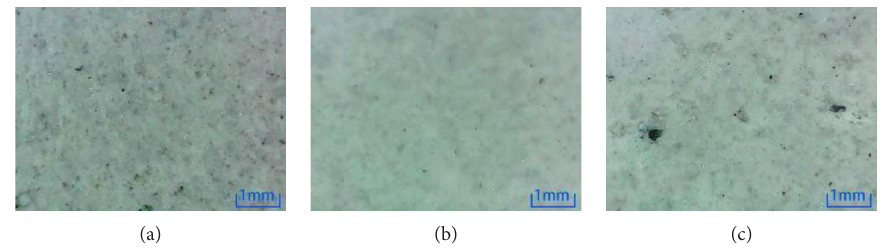
Figure 22: Microscopic observation of water immersion specimen at position 1. (a) 0%. (b) 1%. (c) 2%.